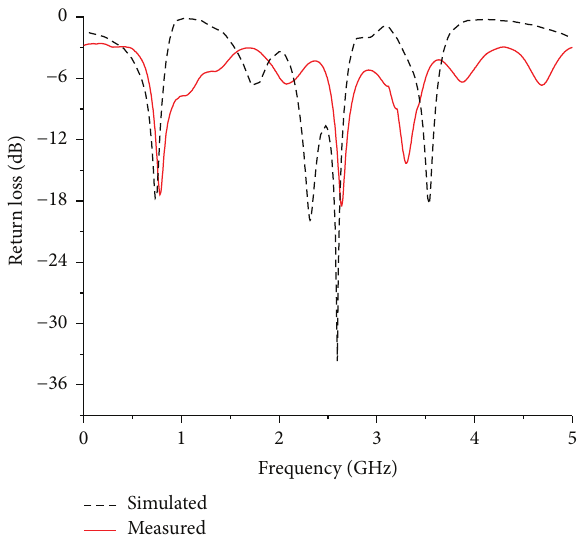
Figure 7: Simulated and measured return loss versus frequencies of the proposed